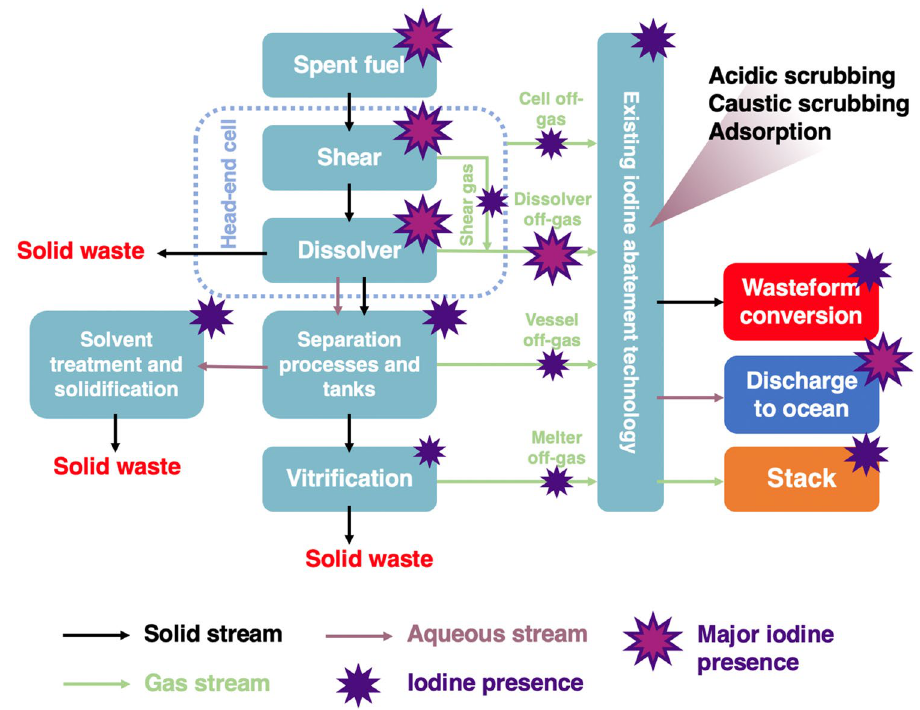
Fig. 1 Generalised schematic of I-129 partitioning in a nuclear fuel recycling system (adapted from [7,